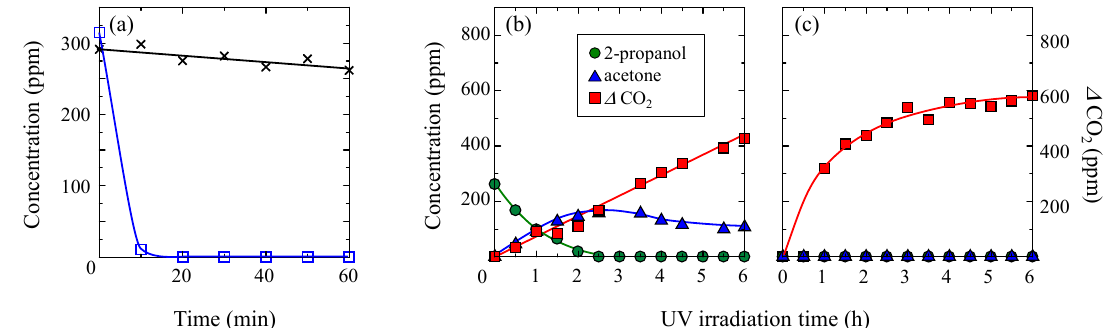
Figure 7. ( a ) Temporal concentration changes of gaseous 2-propanol under dark conditions for the TiO 2 -coated non-porous (crosses) and porous (open squares) glass cloths. ( b , c ) Concentrations of gaseous 2-propanol, acetone, and CO 2 under subsequent UV light irradiation for the TiO 2 -coated non-porous and porous glass cloths, respectively. The porous sample was prepared by 3 h of leaching. The dark adsorption and photocatalytic deposition experiments were conducted at 15 °C and in the presence of low water content (2 mg/L) in a 2-propanol atmosphere.